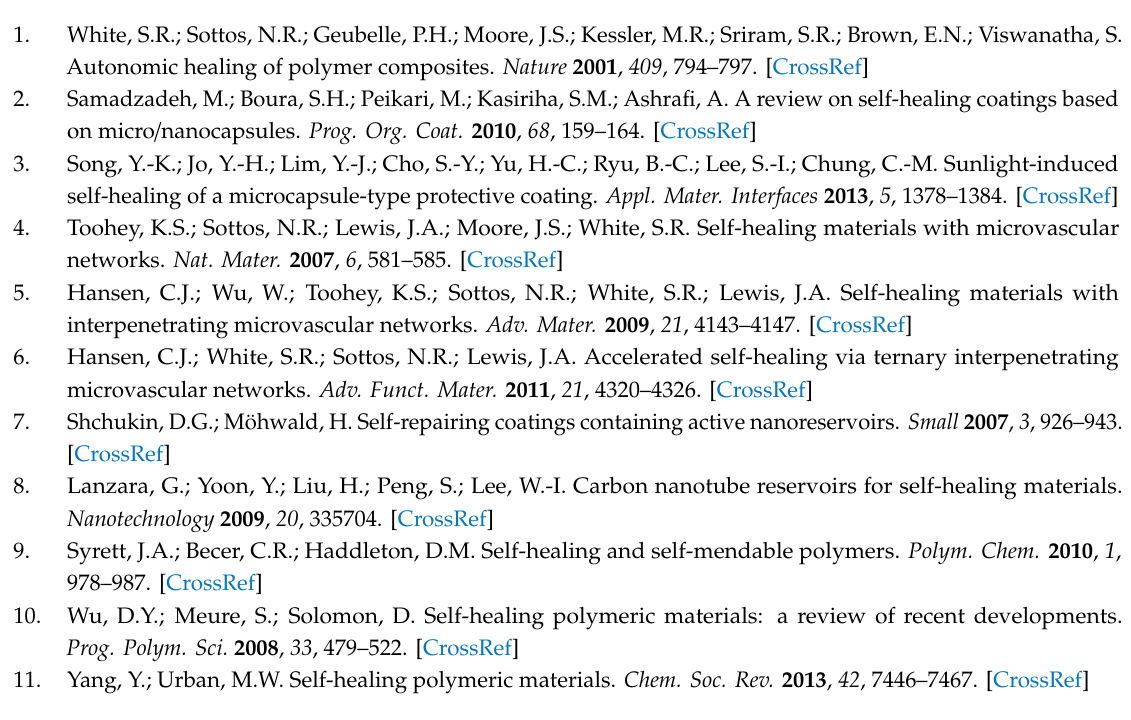
Figure S1: Detail information demonstrating crack image versus healing time at di ff erent